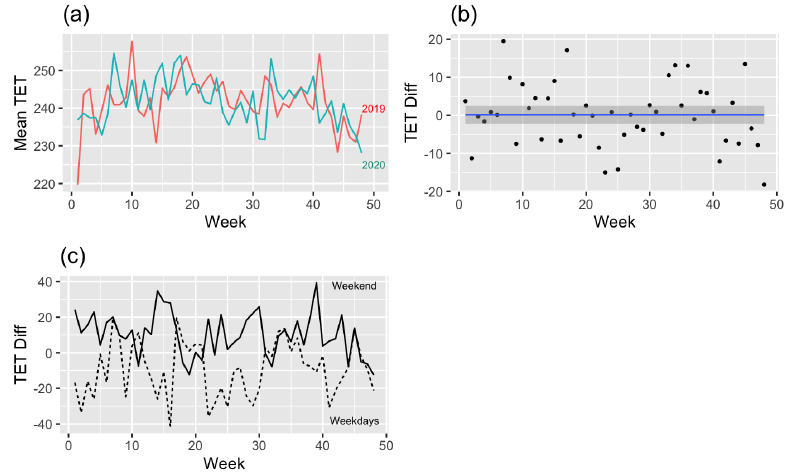
Figure 6. ( a ) Mean total exercise time (2019–2020) by week, ( b ) regression model (linear mixed model) graph of the total exercise time difference (2019–2020), and ( c ) difference in total exercise time of weekdays or weekends